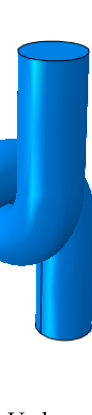
Figure 11. U-shaped ring finite element model. Table 5. Performance parameters of the U-shaped ring.